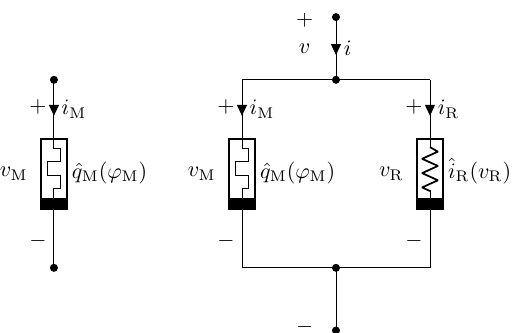
Figure 1. Memristor models: Ideal flux-controlled memristor ( left ) and real extended memristor given by the parallel connection of an ideal memristor and a nonlinear voltage-controlled resistor ( right